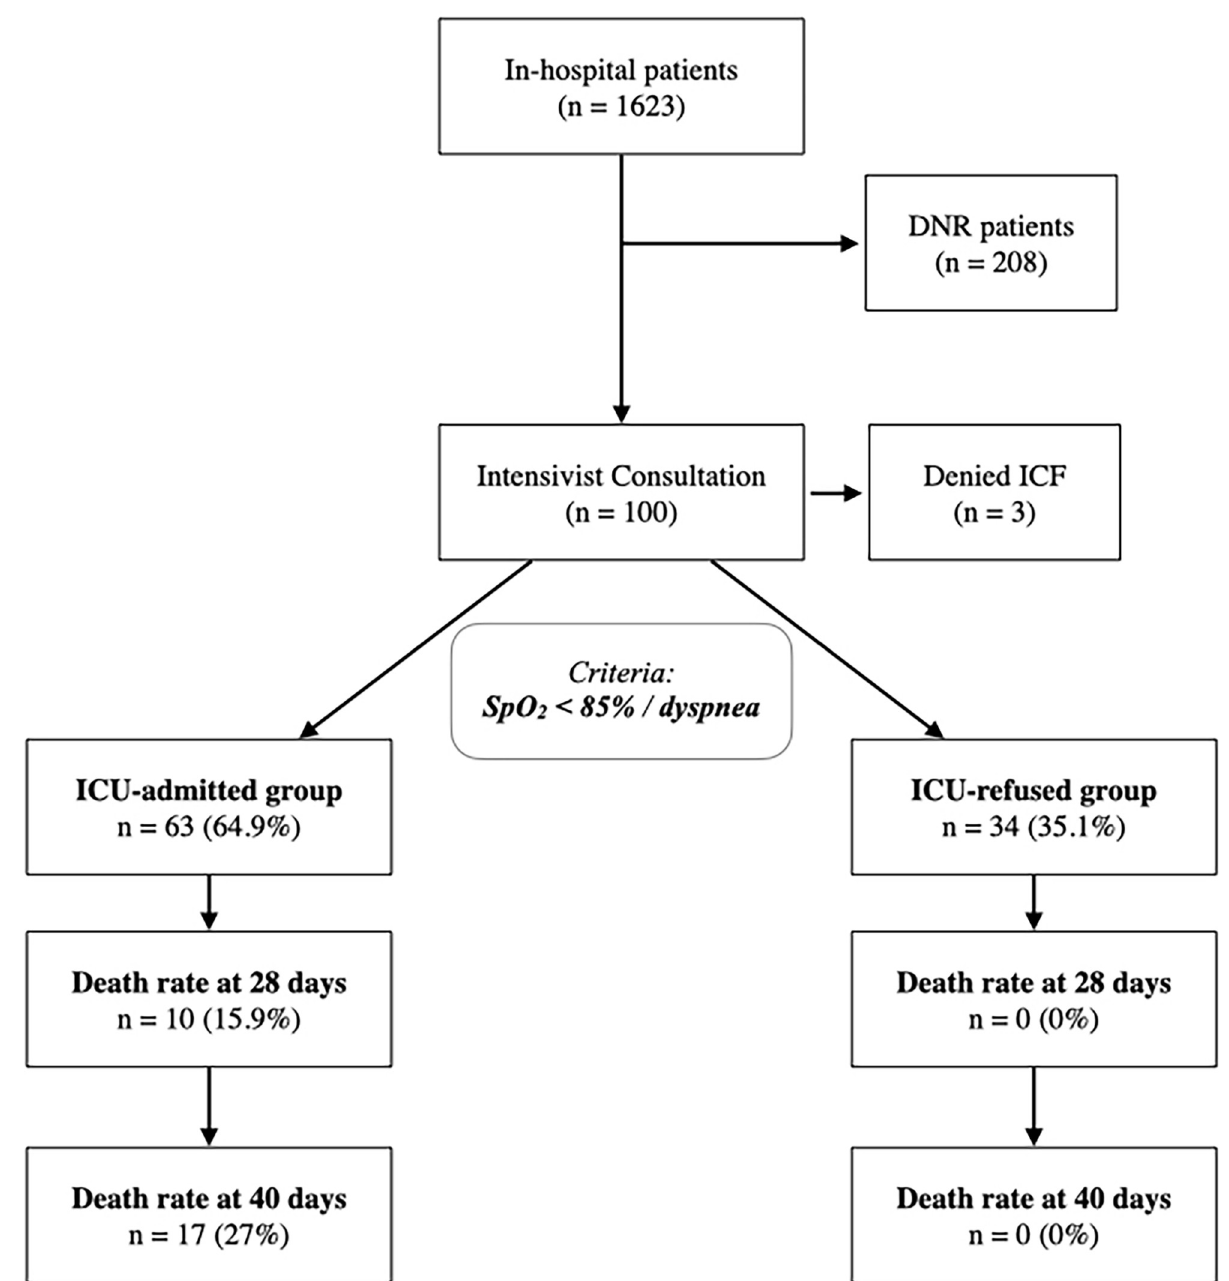
Fig 1. Study design. Management of COVID-19 patients evaluated at our COVID-19 center from March 2020 to January 2021. ICU admission was allowed according to standardized criteria. Patients not admitted followed according to EWS score, to quickly identify any change in their medical status. Death rate at 28 and 40 days is